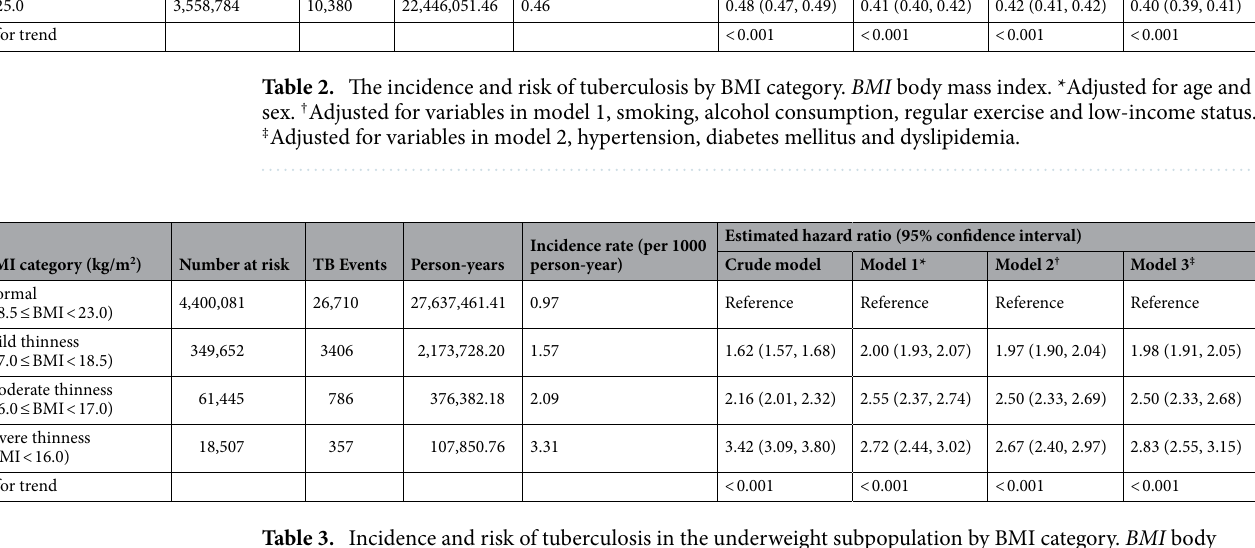
Table 3. Incidence and risk of tuberculosis in the underweight subpopulation by BMI category. BMI body mass index. *Adjusted for age and sex. † Adjusted for variables in model 1, smoking, alcohol consumption, regular exercise and low-income status. ‡ Adjusted for variables in model 2, hypertension, diabetes mellitus and